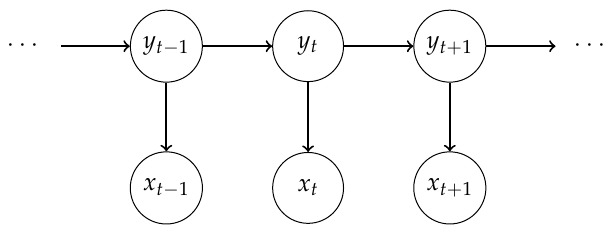
Figure 11. Graphical representation of a Hidden Markov